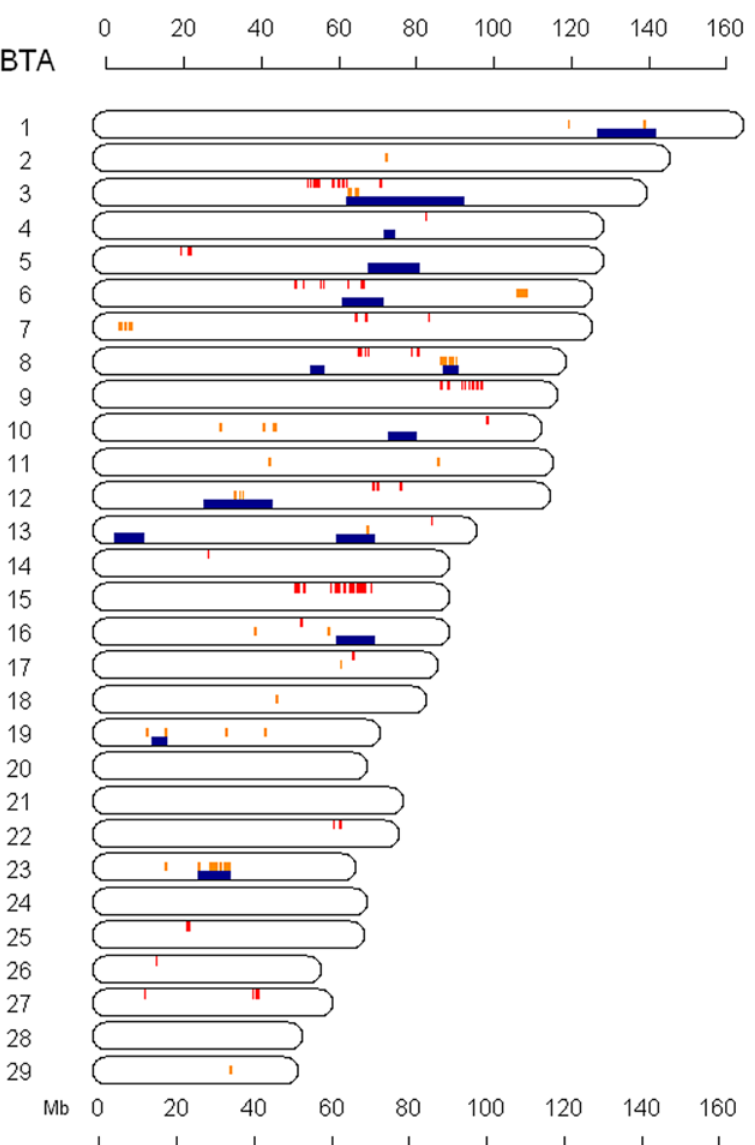
iHS| > 3.0, and ROH > 0.3,